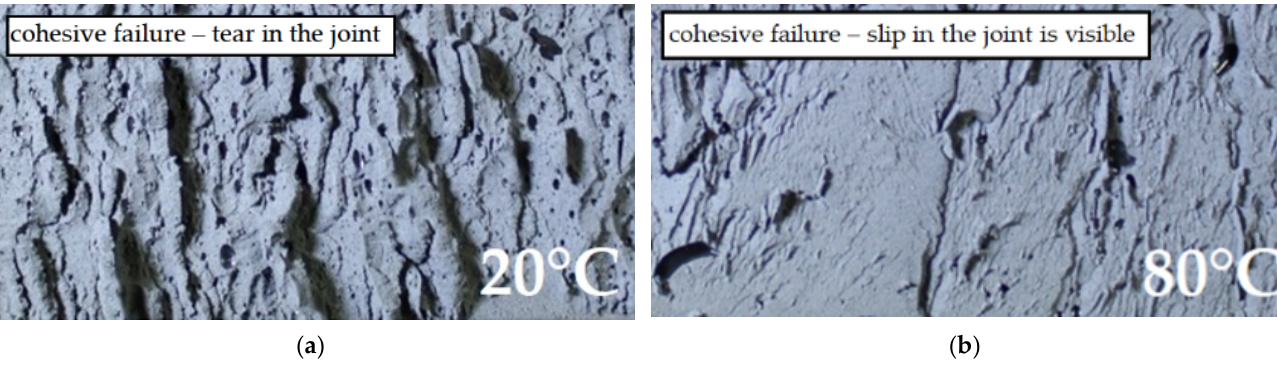
( b ) Figure 14. Failure form in the EP 2579-1 epoxy joint: ( a ) at 20 °C; ( b ) at 80 °C. The results of shear tests of the double shear lap joint for the Sika ® PS and the EP 2579- 1 are presented as force vs. displacement plots in the same scale for the chosen joint thick- nesses (t = 1 mm and t = 4 mm) at two temperature values. Figures 15 and 16 show only one representative curve (close to the mean value) for the four cases (at 20 °C and 80 °C).